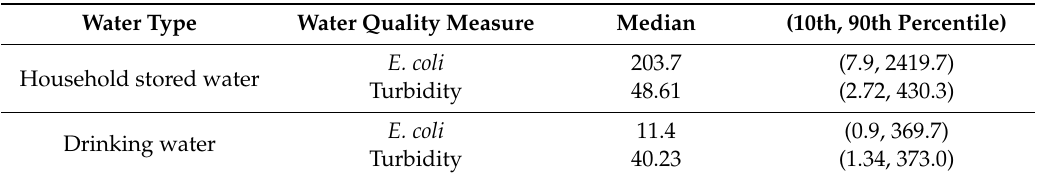
Table 3. Water quality in the homes of participants, Kisian Village. Units of measure for E. coli : MPN / 100 mL. Units of measure for turbidity: NTU. N =